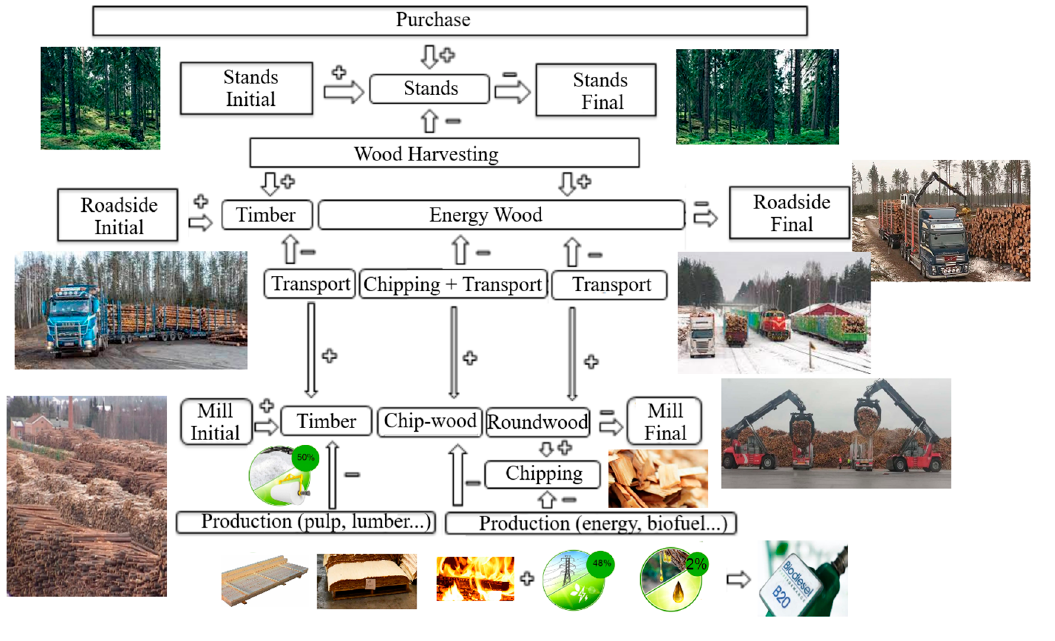
Figure 1. WSCs of IEMI (Modified from [22]).